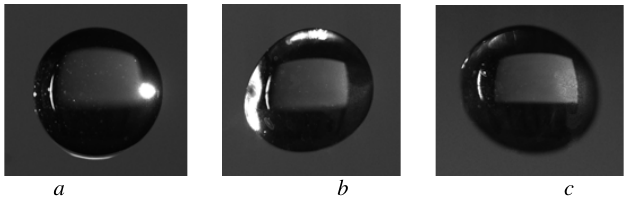
Figure 2. Pictures of water droplets at u = 3 m / s, d 0 = 3mm during a time interval 0 < t < t d : a − t = 0s, / 6, c − t = t / 2. b − t = t d d